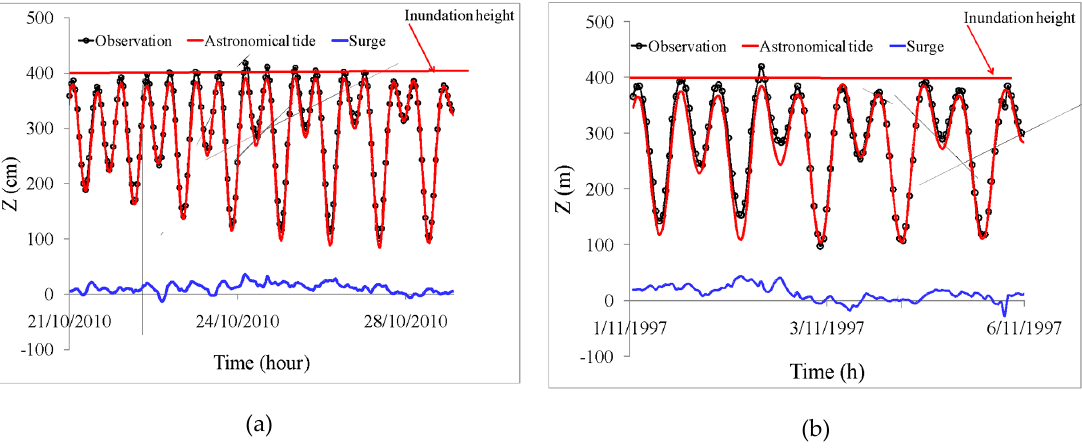
Figure 6. Time series of observed water levels, astronomical tides and surges in Vung Tau ( a ) during spring tide phase in late October and early November 2010 and ( b ) during typhoon Linda (November 1997).